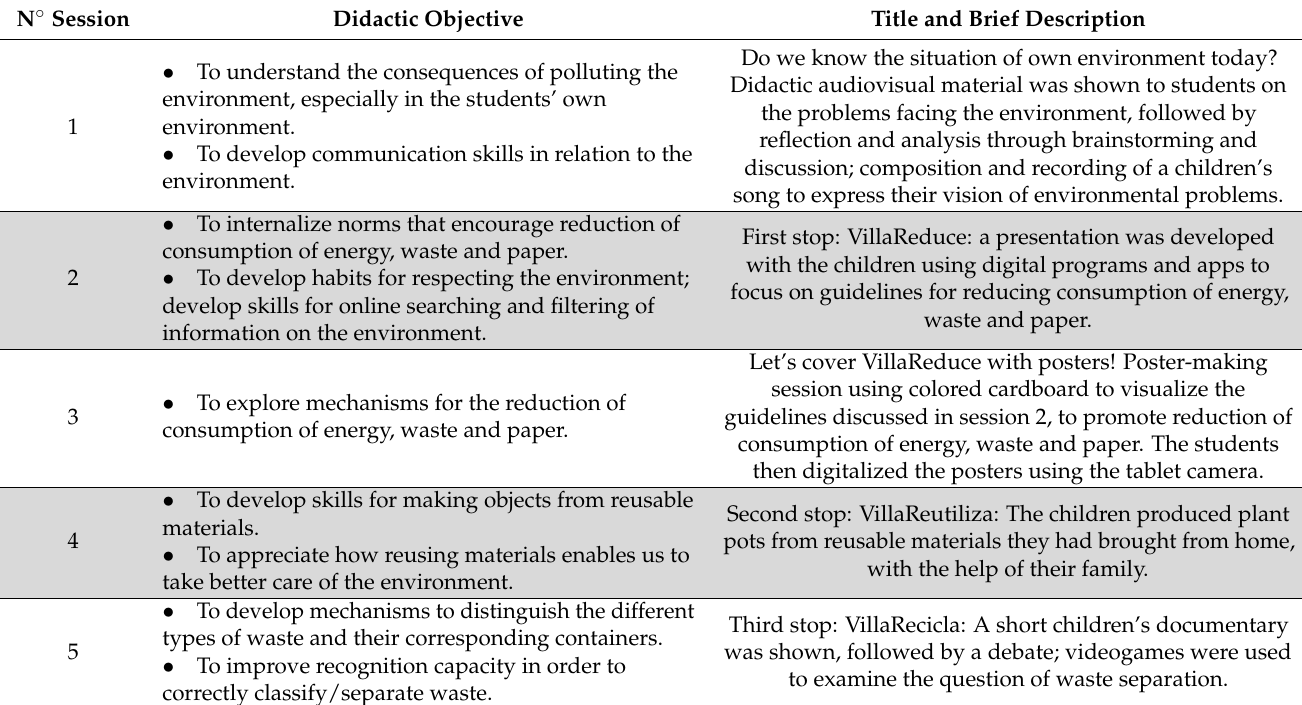
Table 1. Objectives and activities of the educational